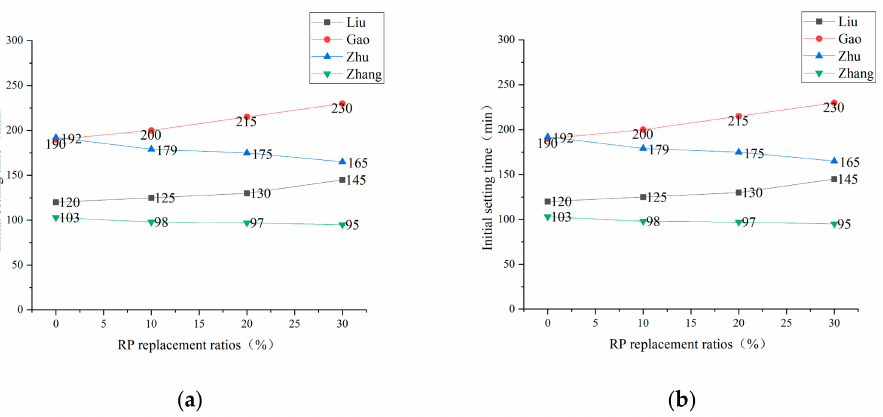
Figure 7. Setting time of net cement paste under different replacement ratios of RP [44,62–64]. ( a ) Initial setting time; ( b ) Final setting